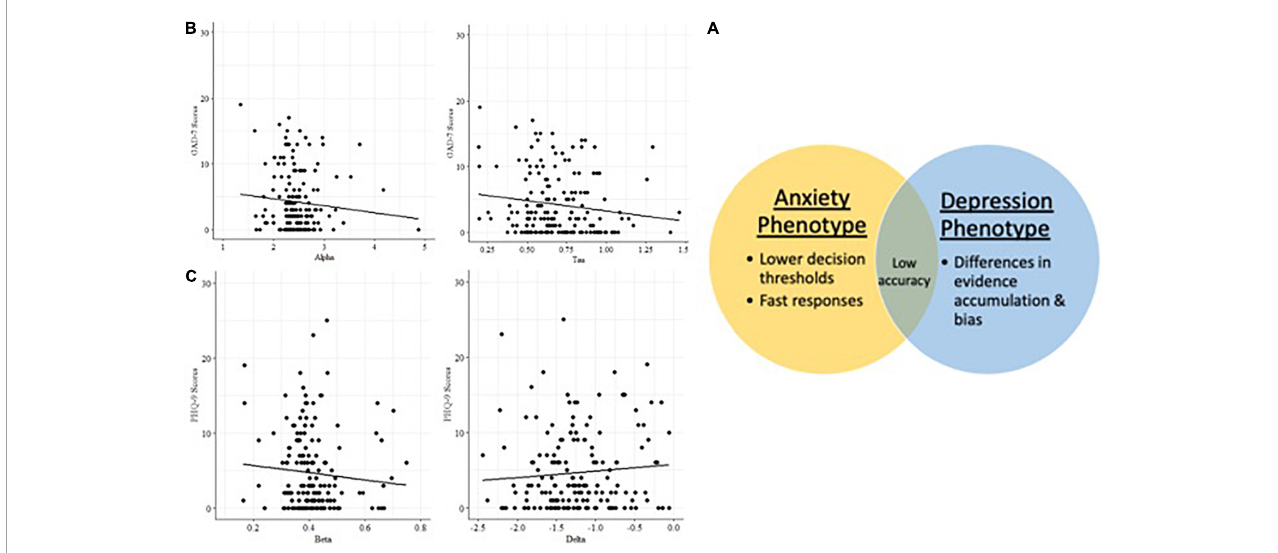
FIGURE6 (A) Latent cognitive variables associated with anxiety and depression phenotypes in Visual Search. (B) Anxiety phenotype: decision boundary and non-decision time. (C) Depression phenotype: bias and drift